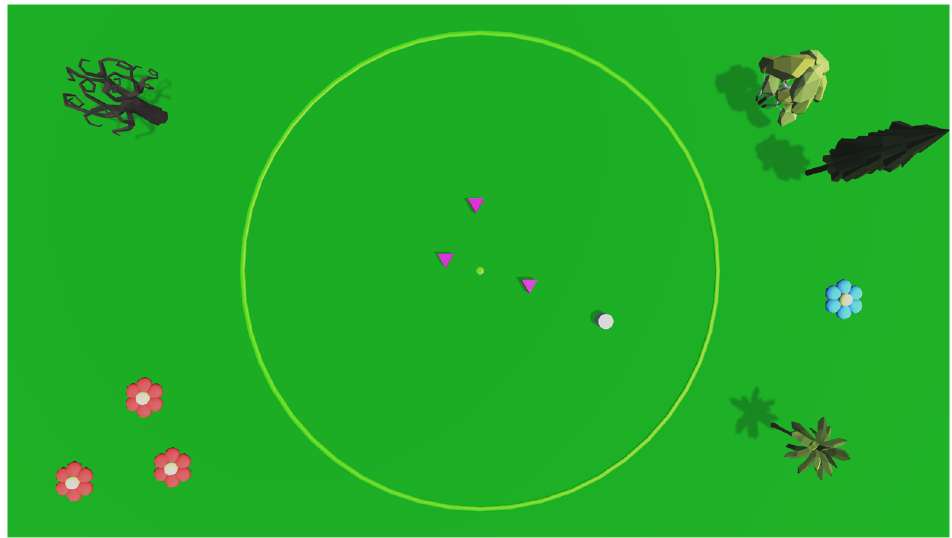
Figure 1. Screenshot of the Sheep Herding task. The three sheep objects are depicted as purple inverted triangles. The dog object is the white circle. The green circle is the sheep pen.